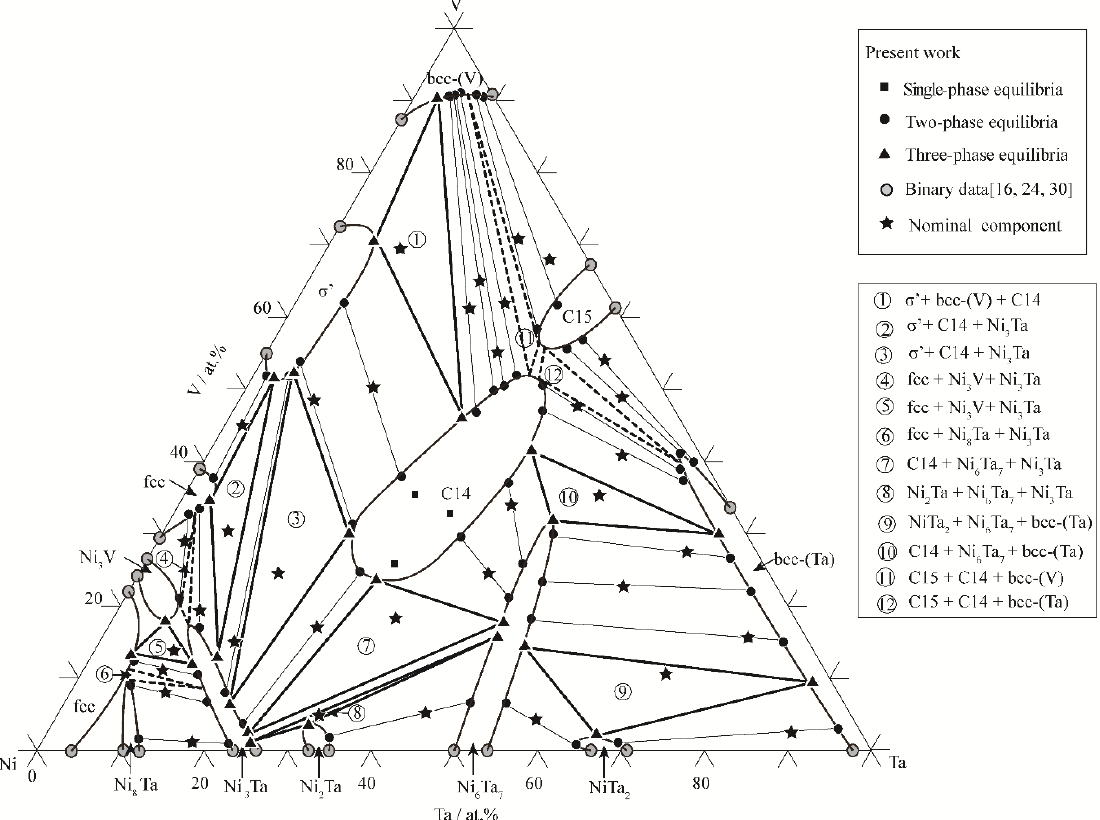
Figure 4. Experimentally determined isothermal section of the Ni-V-Ta system at 1000 °C.